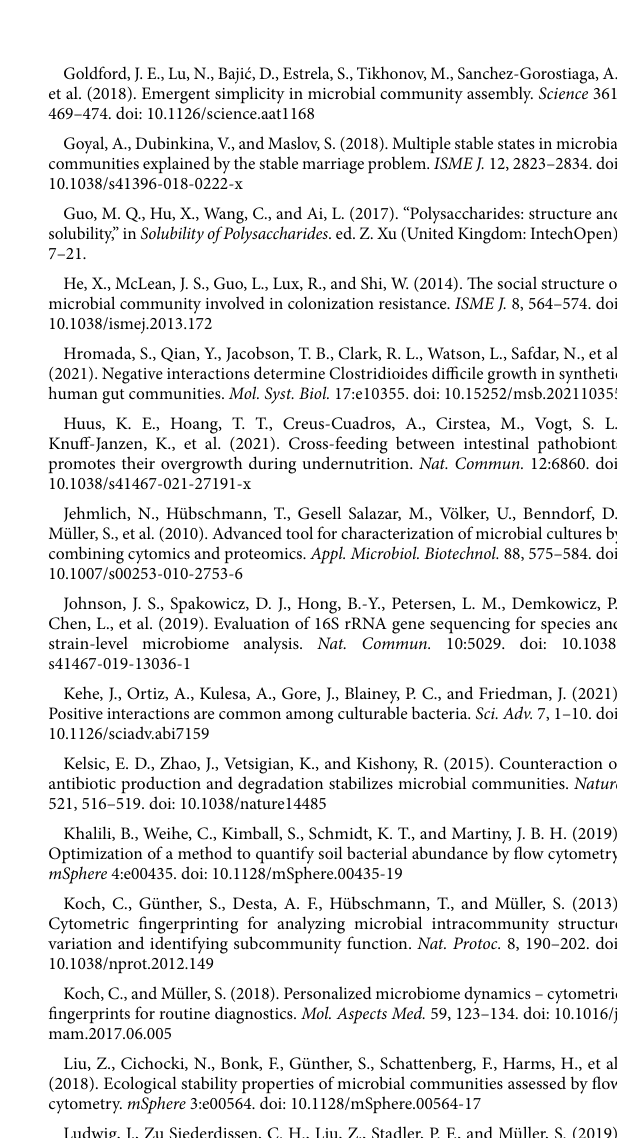
SUPPLEMENTARY FIGURE 6 Absolute abundances of Bacteroides species in co-cultures on minimal media supplemented with single carbon